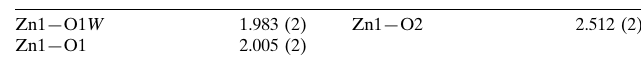
Selected bond lengths (A˚ ).